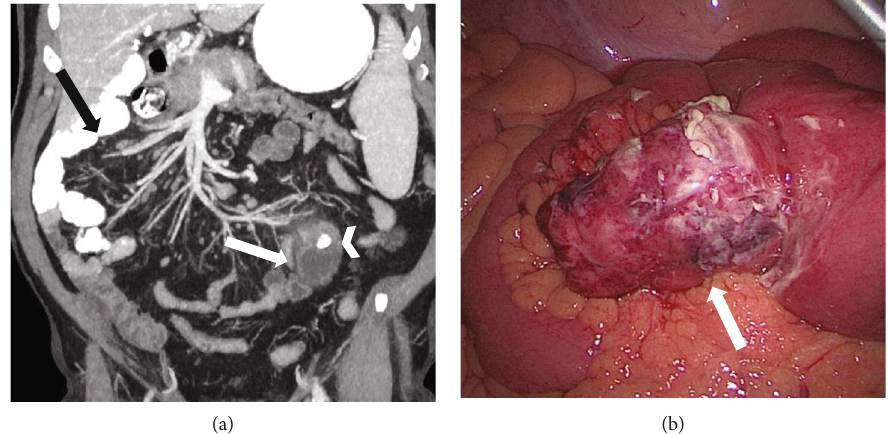
Figure 1: (a) Coronal reformatted contrast-enhanced CT images thickened with maximal intensity projection demonstrate malrotation of the small intestine with the jejunum and a large part of the ileum placed on the right side of the abdomen (black arrow). In the left hemiabdomen is a blind-ending tubular structure arising from the distal small bowel (white arrow), which has a markedly thickened wall with extensive surrounding fat stranding. Note the intraluminal calci fi ed lesion (white arrowhead) contained in the saccular structure. (b) Laparoscopic view of perforated Meckel diverticulitis.